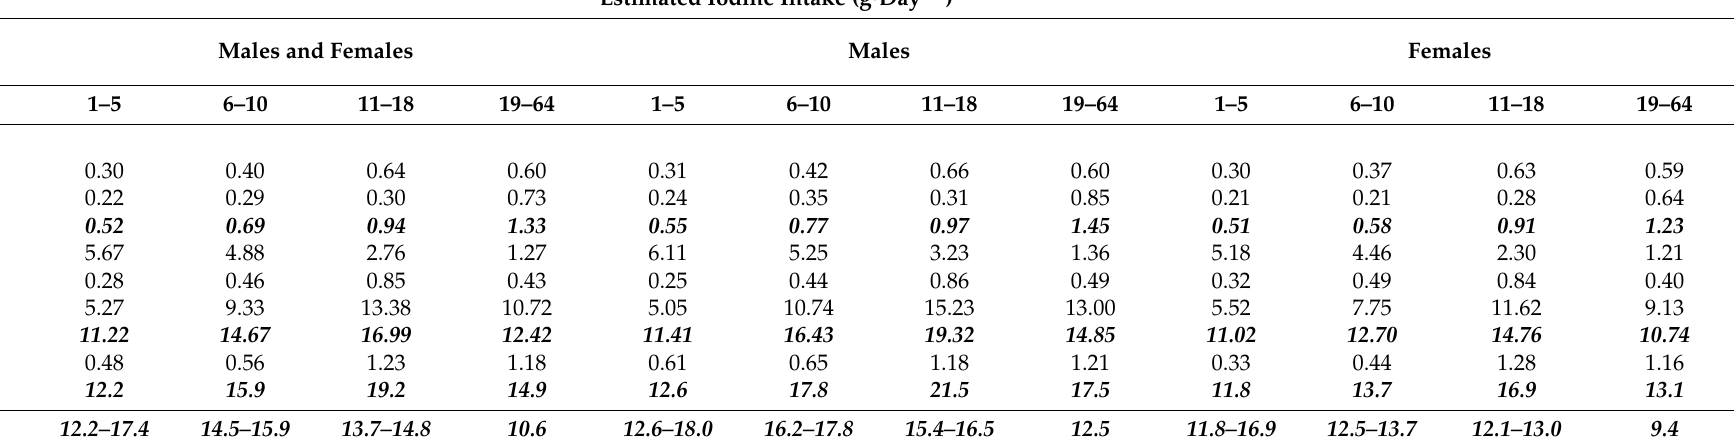
Table 5. Estimated iodine intake ( µ g · day − 1 ) of UK individuals, based on age and gender, including non-consumers, from seafood consumption using iodine results from the present study and seafood intake calculated from NDNS disaggregated data seafood type (years 1–8 combined [50]) shown in Table 4. Data shown include non-seafood